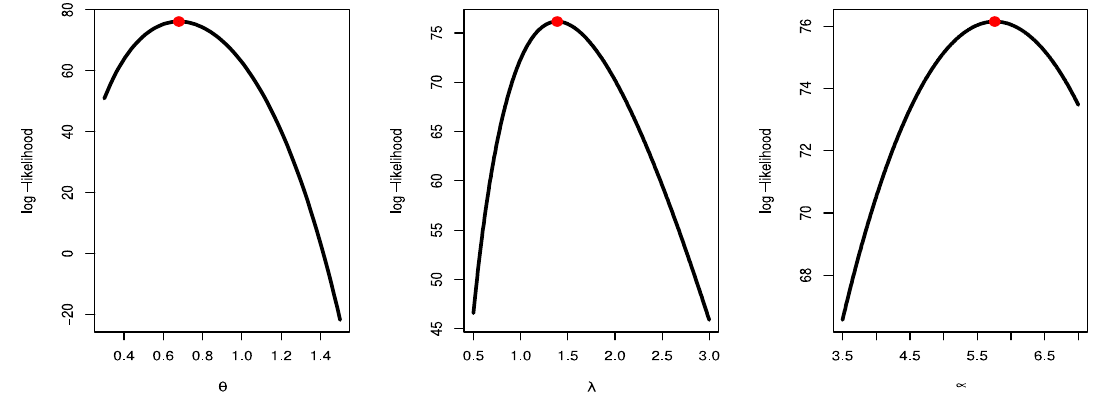
Figure 14. Likelihood profile for parameters of TCPWE distribution for COVID-19 data.